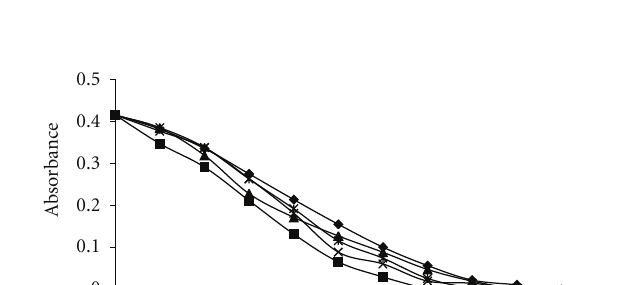
Figure 4: XRD patterns of powder samples.